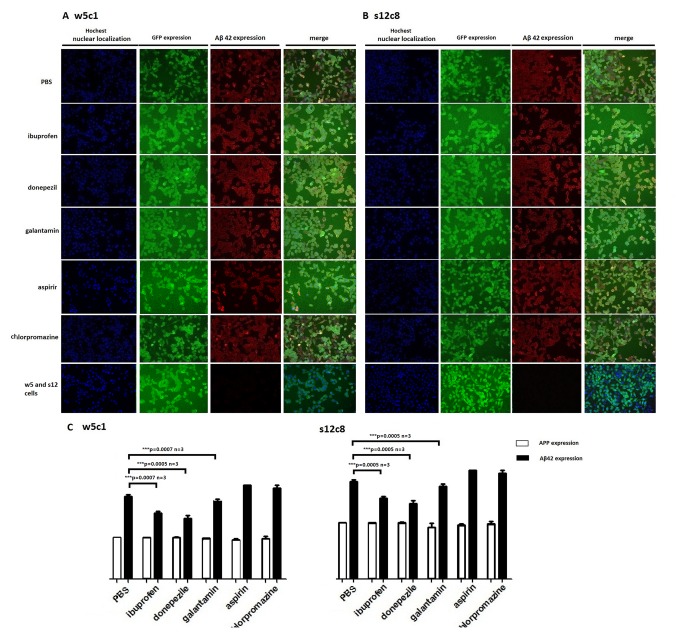
Effect of inhibitors of secretase activity on Aβ42 levels in our engineered cell lines assayed by High Content analysis.Cell lines w5c1 and s12c8 cells were stained for nuclei with Hoechst 33342 (blue), and GFP expression (green) was used to identify cells and APP location. Aβ42 expression was identified by tetramethylrhodamineisothiocyanate (TRITC, red). Images were acquired with the ArrayScan HCS reader with a 10x objective. Quantitation was performed with the Cell Health Profiling BioApplication (Cellomics, Pittsburgh, PA, USA). Cells were treated with ibuprofen, donepezil, galantamin, aspirin and chlorpromazine. PBS was used as a control. Data were obtained from three independent experiments, each performed in triplicate, and expressed as mean ± SD. Error bars represent SD. (A) Activity of drugs in cell line w5c1 measured by High Content. (B) Activity of drugs in cell line s12c8 measured by High Content. (C) Quantification of changes in APP and Aβ42 levels between drugs treatment groups. APP was detected in High Content using the anti-human APP Thr668 antibody as primary antibody, CST #2452, and a secondary antibody with TRITC as the reporter (data are not shown).Aβ42 expression in cells is significantly inhibited by ibuprofen, donepezil and galantamin in both the w5c1 and s12c8 cell lines. No significant change in the abundance of APP was seen in either cell lines after drug treatment. Results were obtained from three independent experiments, each performed in triplicate, and expressed as mean ± SD. Error bars represent SD. Asterisk indicates a statistically significant difference between two groups (*p<0.05, **p<0.01, ***p<0.001).